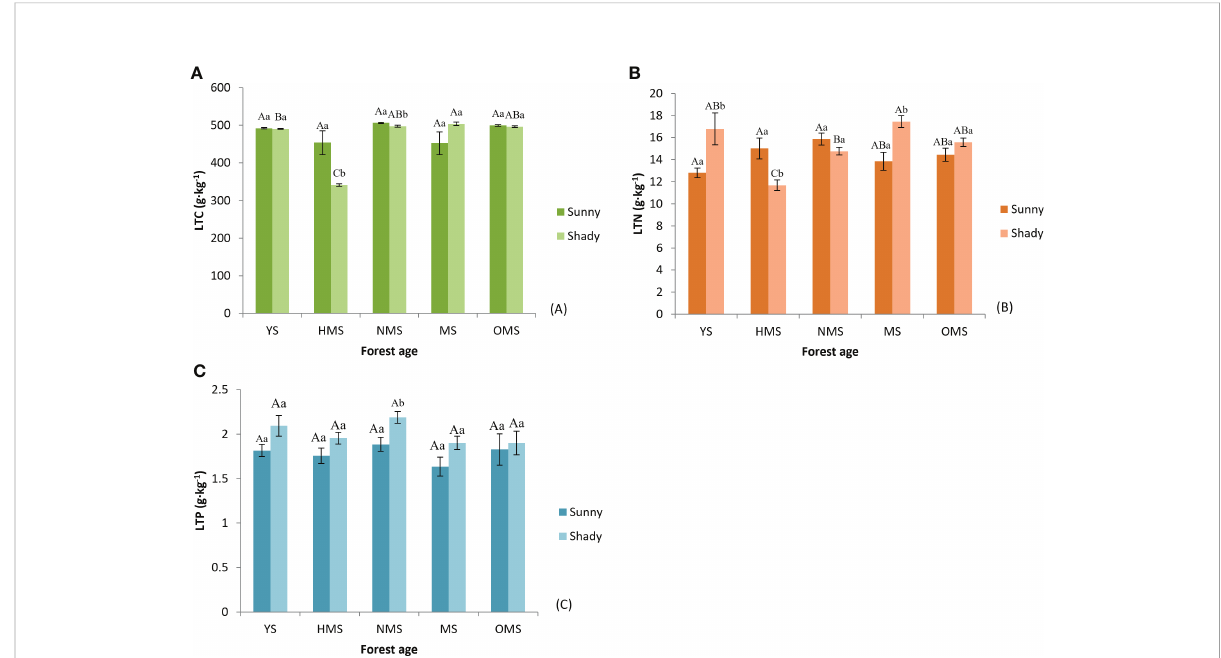
FIGURE 2 The total carbon of leaf (A) , total nitrogen of leaf (B) , and total phosphorus of leaf (C) . Different capital letters indicate signi fi cant differences in forest ages, and different lowercase letters indicate signi fi cant differences sites conditions ( p< 0.05). YS, Young stage; HMS, Half-mature stage; NMS, Near-mature stage; MS, Mature stage; OMS, Over-mature stage; Sunny, Sunny slope; Shady, Shady